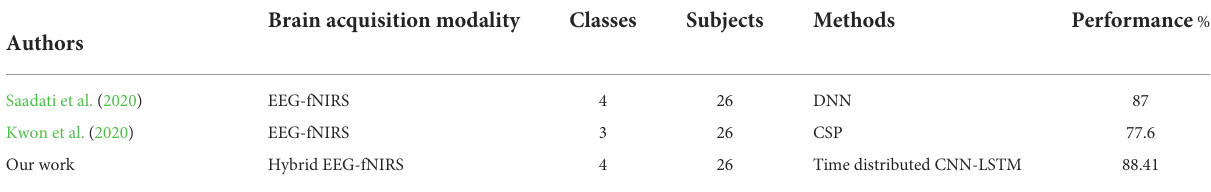
TABLE 3 Comparison with other 4-class hybrid classification studies for BCI with same